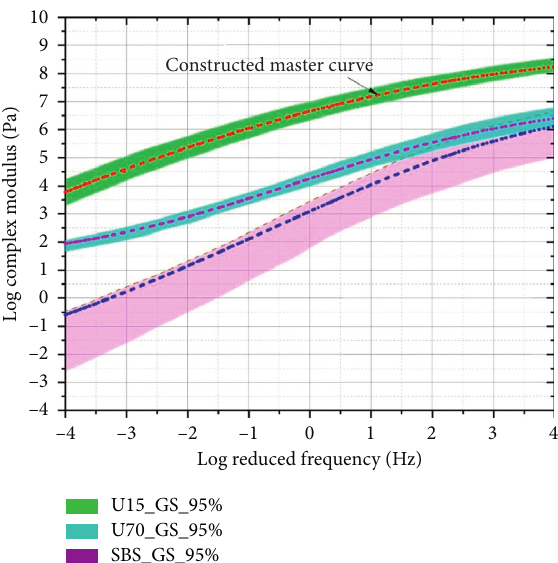
Figure 6: Master-curve bands of different bitumen binders.